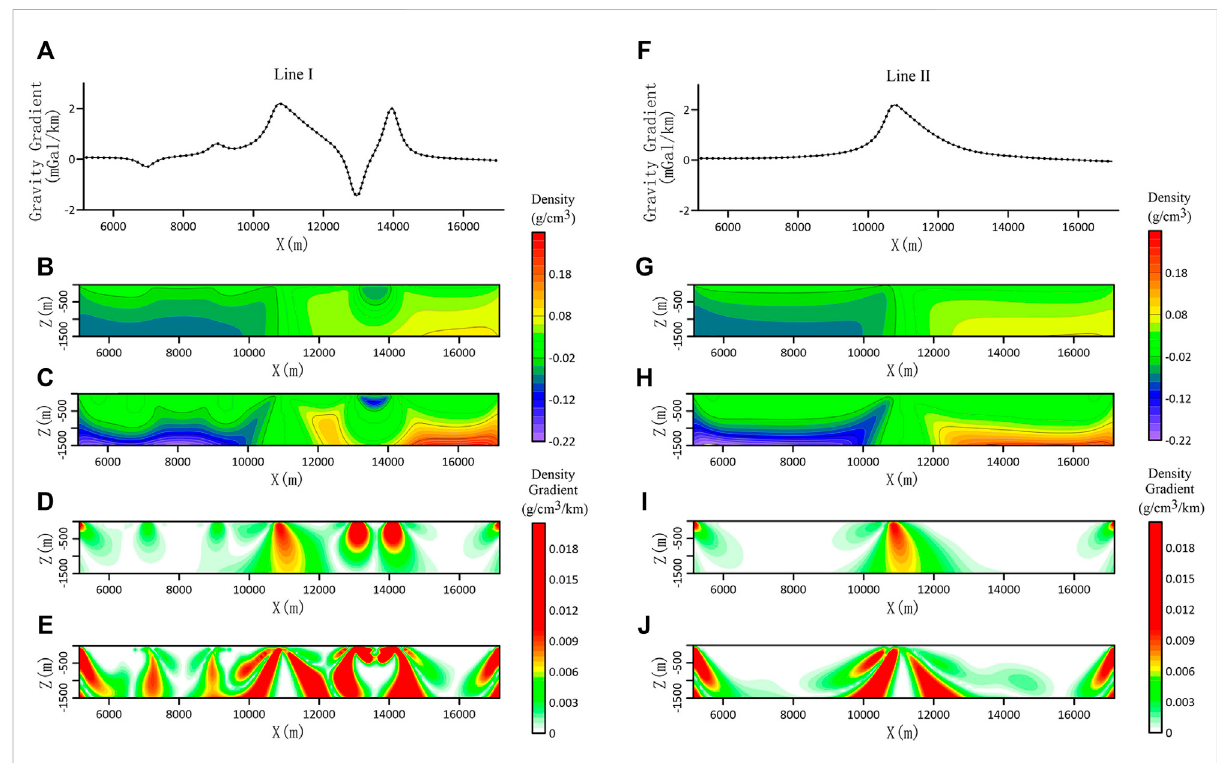
FIGURE 9 Horizontal gravitygradientcurveandgradient inversion resultpro fi leinthex-directionoflinesIandII. (A) Horizontal gradient anomalycurveof gravity in the x-direction on line I. (B) Slice the inversion result of line I without focusing constraint. (C) Slice of line I focusing inversion results. (D) (E) Horizontal derivative in the x-direction of Figures b and c. (F) Horizontal gradient anomaly curve of gravity in the x-direction on line II. (G) Slice the inversionresultoflineIIwithoutfocusingconstraint. (H) SliceofIIlinefocusinginversionresults. (I)(J) Horizontalderivativeinthex-directionof images (G) and (H)